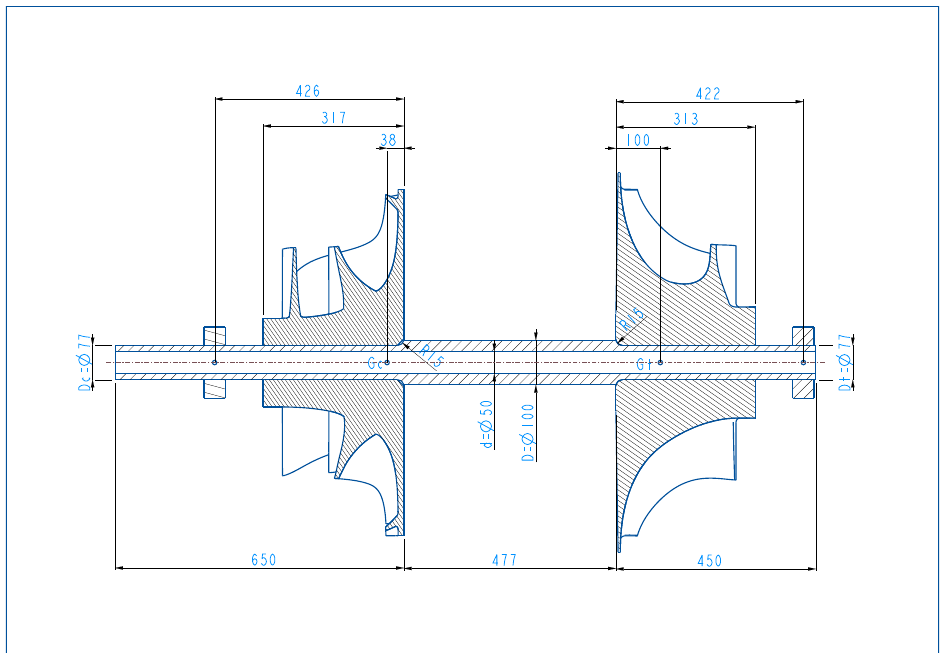
Figure 8. Layout of the shaft line, including compressor and turbine impellers with center of mass G c and G t and radial plain bearings; all dimension units are millimeters (mm).